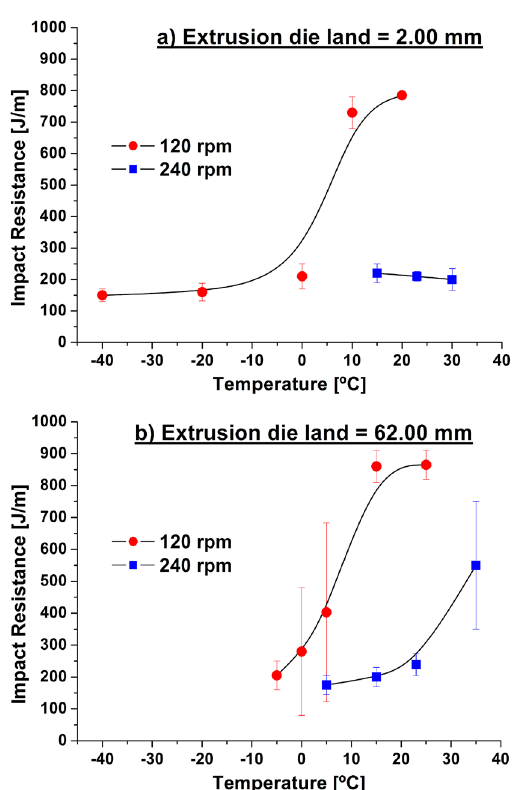
Figure 2. Influence of the rotation speed of the screw 4KB45/5/42 on the impact resistance and DBTT of the PBT/ABS blends with extrusion dies which lengths were a) die land of 2.00 mm and b) die land of 62.00 mm.